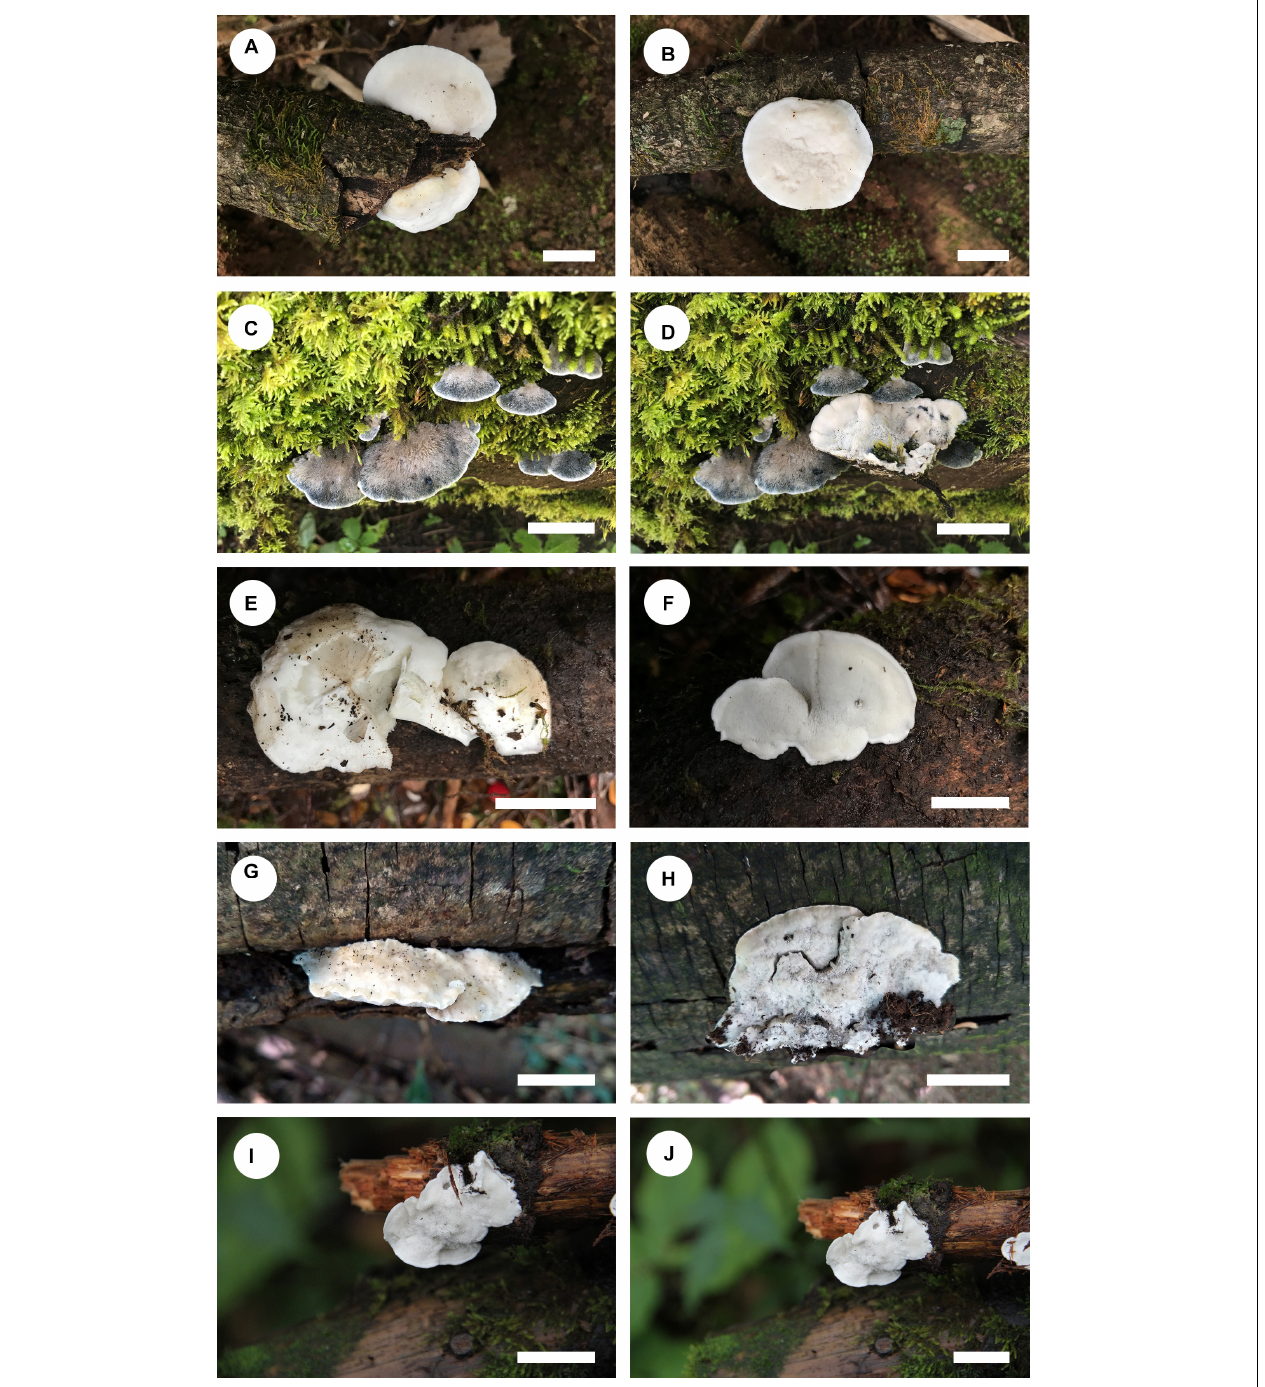
FIGURE 4 | Basidiocarps of Cyanosporus species. (A,B) C. bubalinus ; (C,D) C. hirsutus ; (E,F) C. nothofagicola ; (G,H) . C. submicroporus ; (I,J) . C. tenuis (scale bars: A,B,I,J = 1 cm; C,D,E,F,G,H = 2 cm).